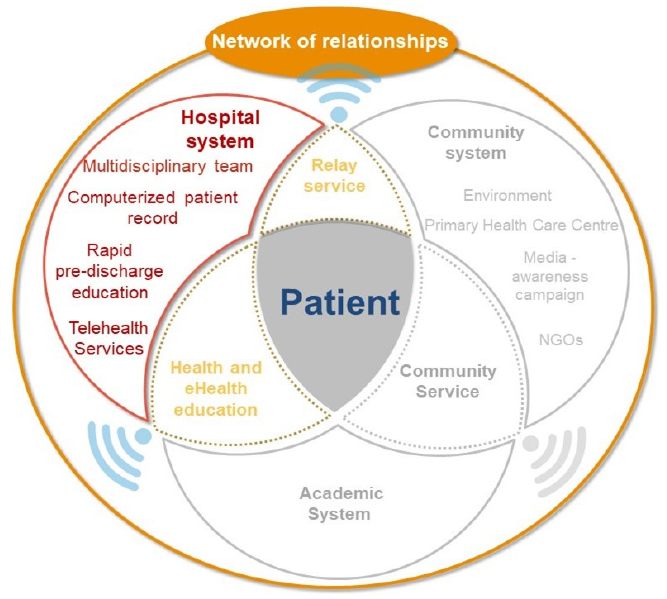
Figure 4. Hospital system.